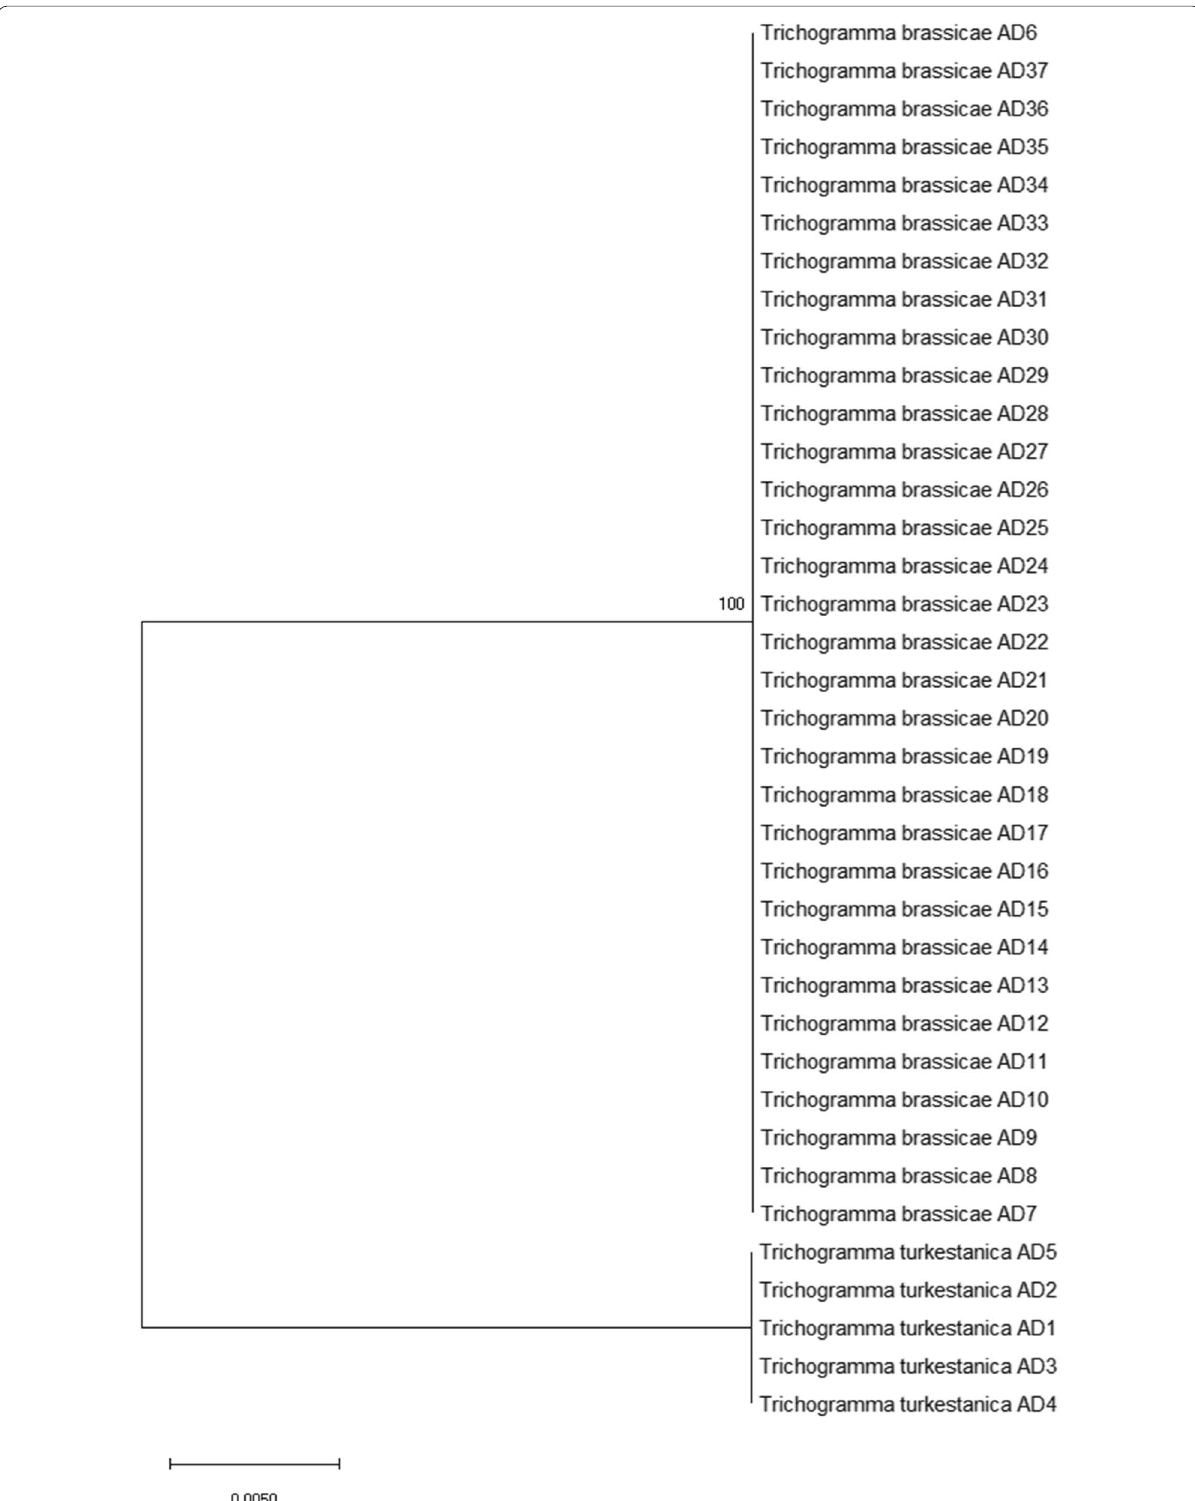
Fig. 1 Phylogenetic tree based on ITS2 gene region of Trichogramma specimens of 37 different studied samples (AD1-AD37) was constructed by using the Maximum Likelihood method based on the Kimura 2-parameter model with a uniform distribution to model evolutionary rate differences among sites. Numbers on the branches indicate the bootstrap values of